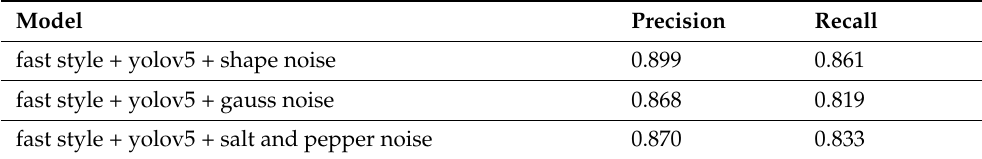
Table 10. Detection result for 3 types of noise.